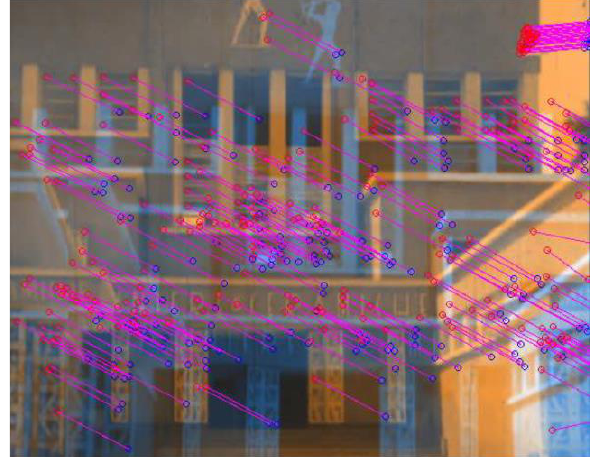
Figure 10. Tie Point selection between two adjacent video frames (Condorelli et al., 2018)